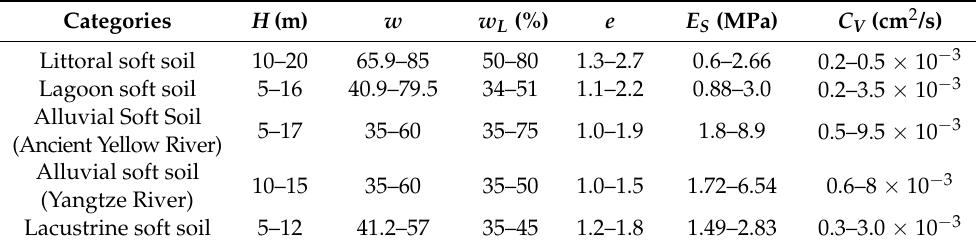
Figure 1. Distribution of 5 soft soil areas. Table 2. Engineering properties of soft soil